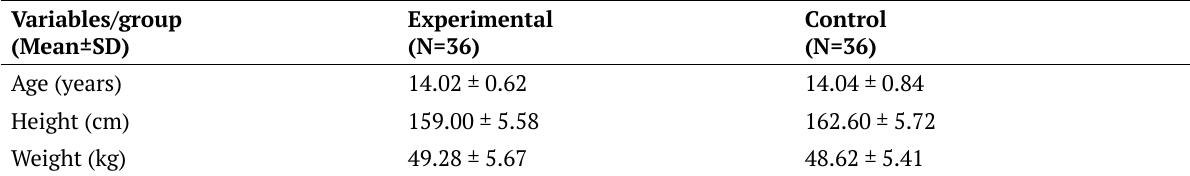
Table 1. Demographic data of experimental and control groups Variables/group